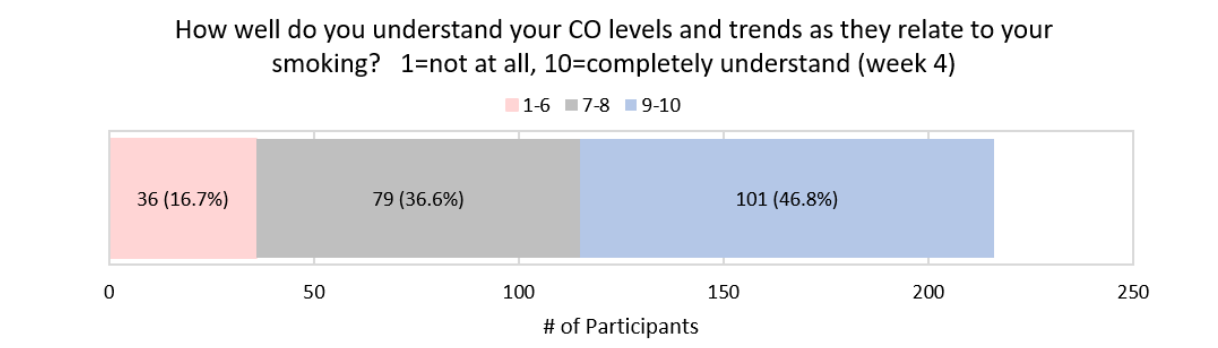
Assessment of participant breath sensor use revealed regular daily use that decreased over time, with a mean of 3.8 (SD 2.2) samples per day at 1 week compared with 1.3 (SD 2.2) at 12